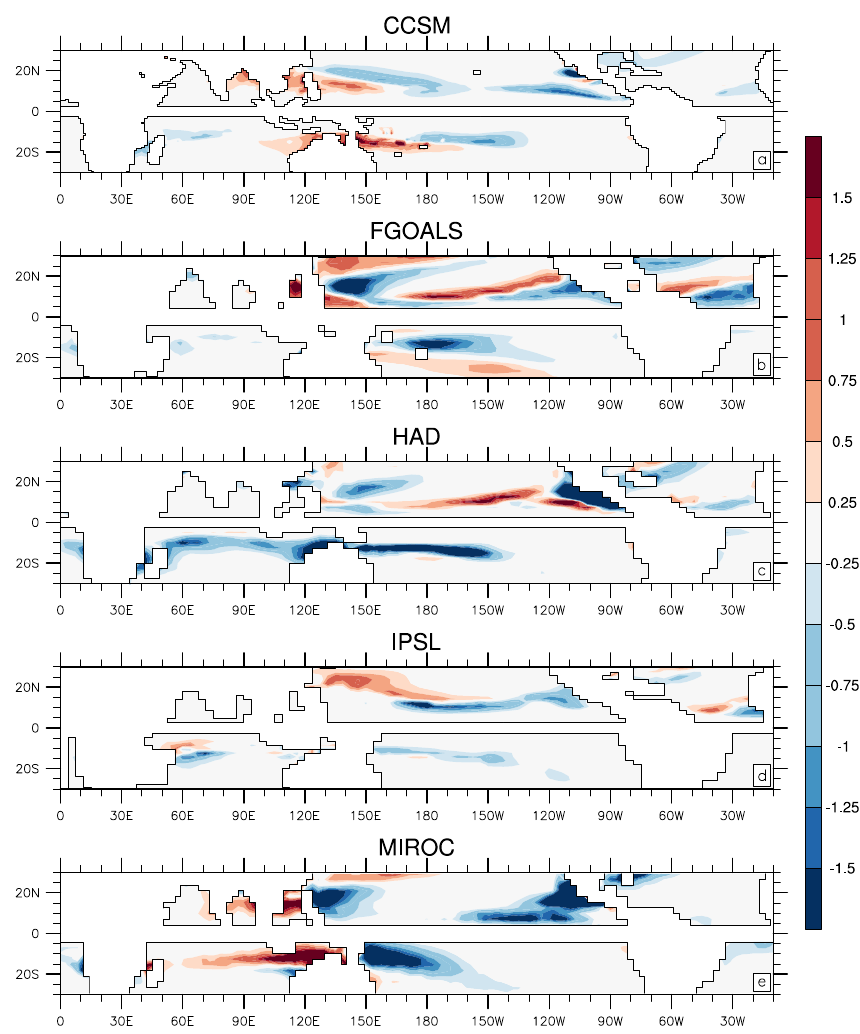
Figure 7. Change in genesis potential index between the Pliocene and the preindustrial period in the Northern Hemisphere (JASO) and the Southern Hemisphere (JFMA) for (a) CCSM4, (b) FGOALS, (c) HadCM3, (d) IPSL, and (e) MIROC4m. Units are in 10 − 13 normalised occurrences m − 2 month − 1